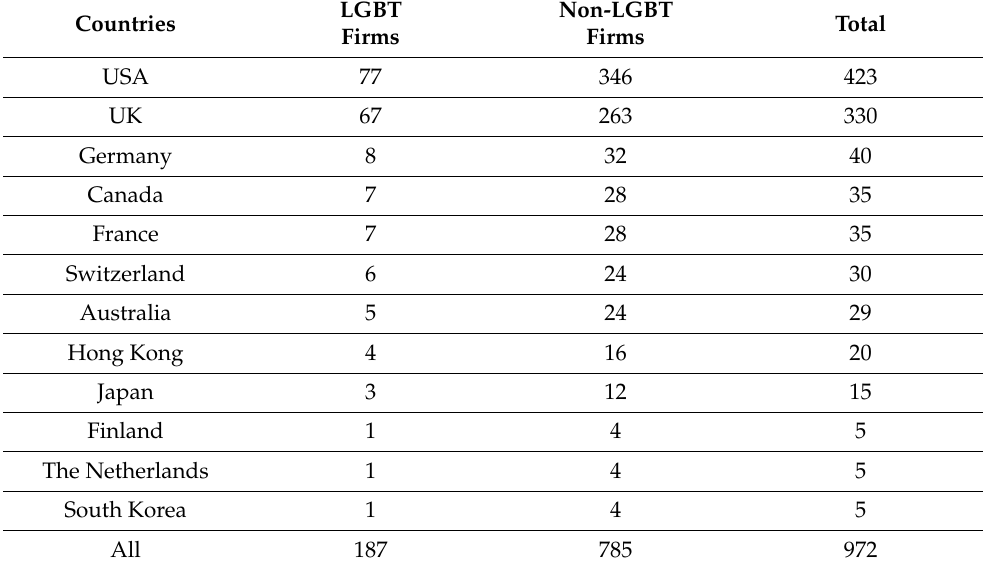
Table 1. Sample distribution by country and by type of firm. Countries